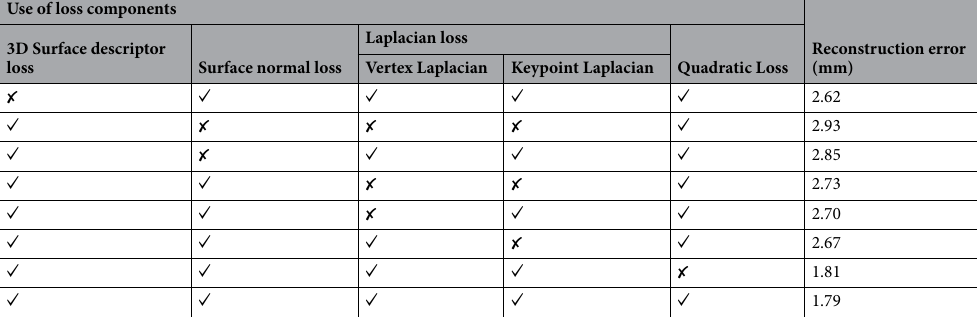
Table 1. Results of the conducted ablative studies to evaluate the effectiveness of the loss components that are indicated in Eq. (4) and in Eq. (9). The first row demonstrates the importance of using the 3D surface descriptor, where as the next five rows (highlighted in gray) demonstrate the effectiveness of surface smoothness and the seventh row demonstrates the effectiveness of the quadratic loss.